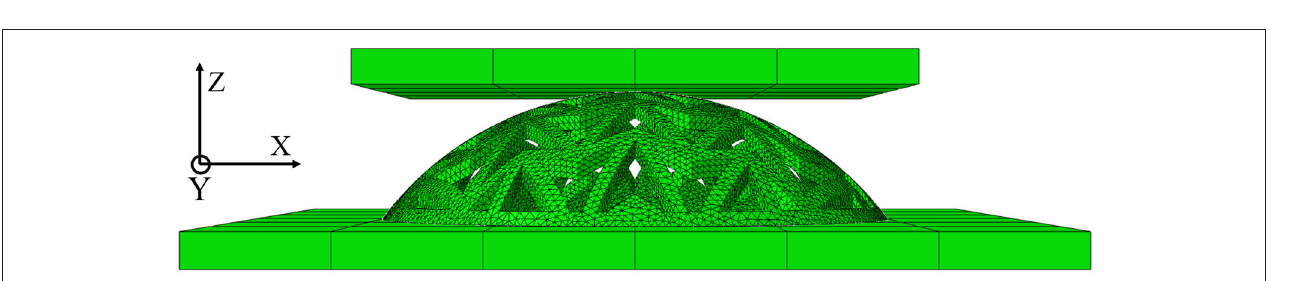
FIGURE 5 | The loading rig for the DIC application (Left) and a schematic of the positioning of the cameras (Right) .